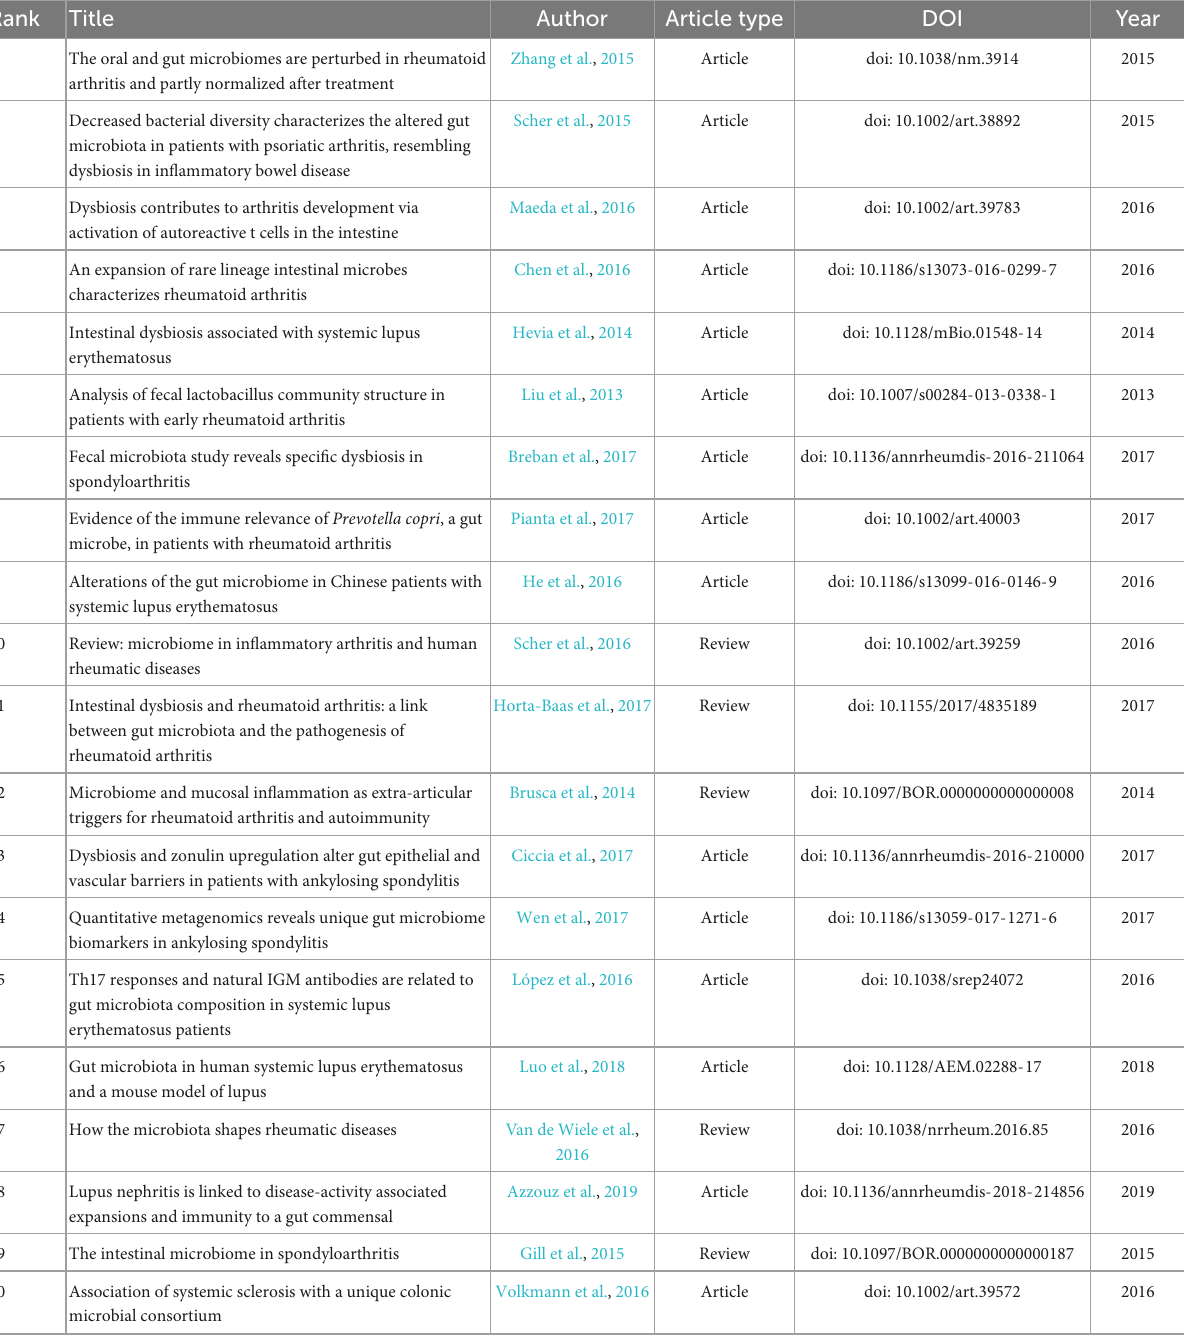
Localciteddocumentsrefertothedocumentscitedbyotherarticlesinourdatabase.